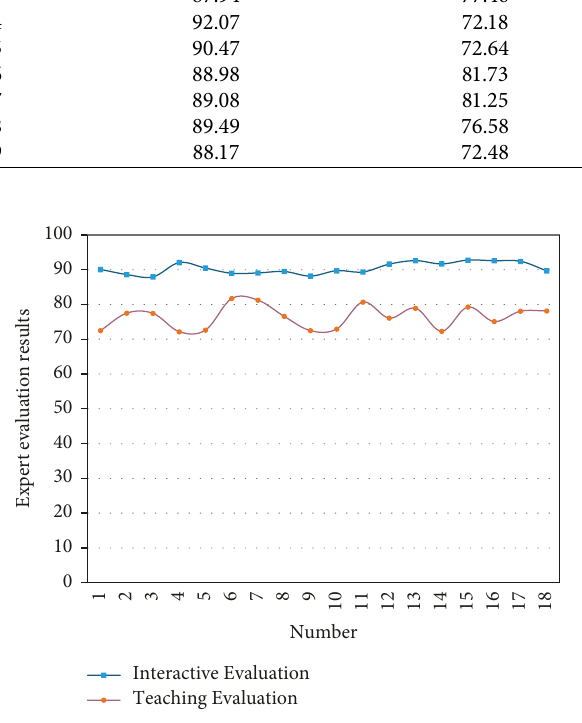
Figure 9: Statistical diagram of expert evaluation